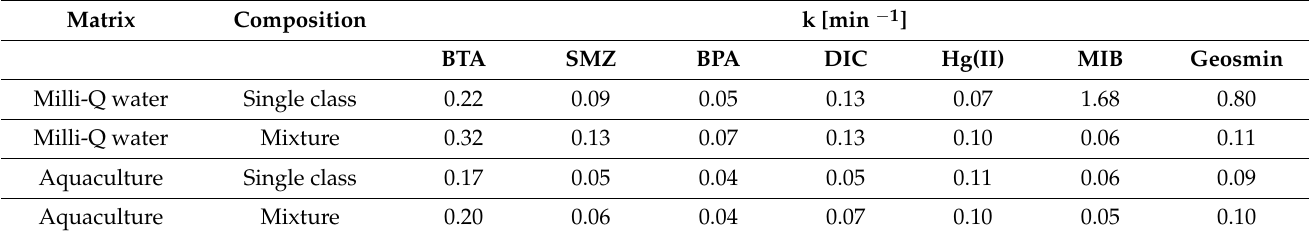
Table 1. Comparison between the kinetic constants obtained with the ZCC photocatalyst for the removal of the evaluated pollutants, individually and in a mixture of them in two different matrices: Milli-Q and real aquaculture